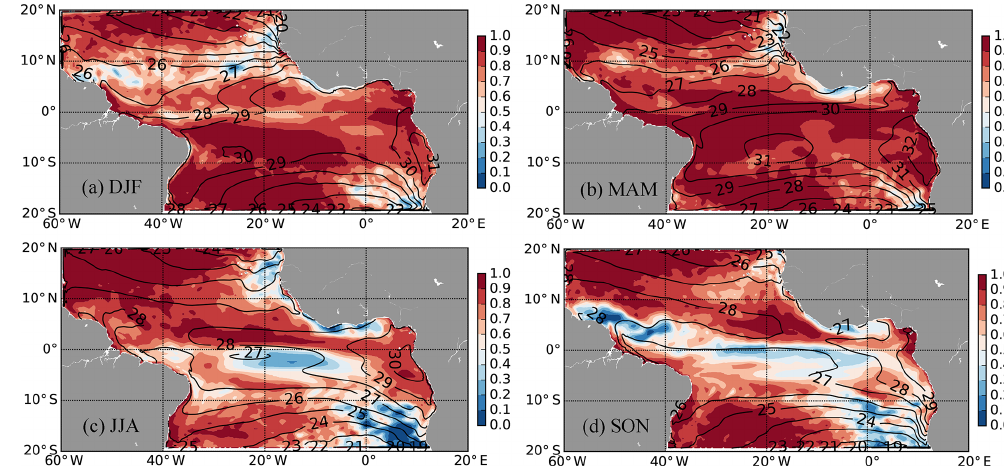
Figure 6. Coefficient of determination ( R 2 ) between BIASED and BIASED- τ clim seasonal SST time series, as in Fig. 4.